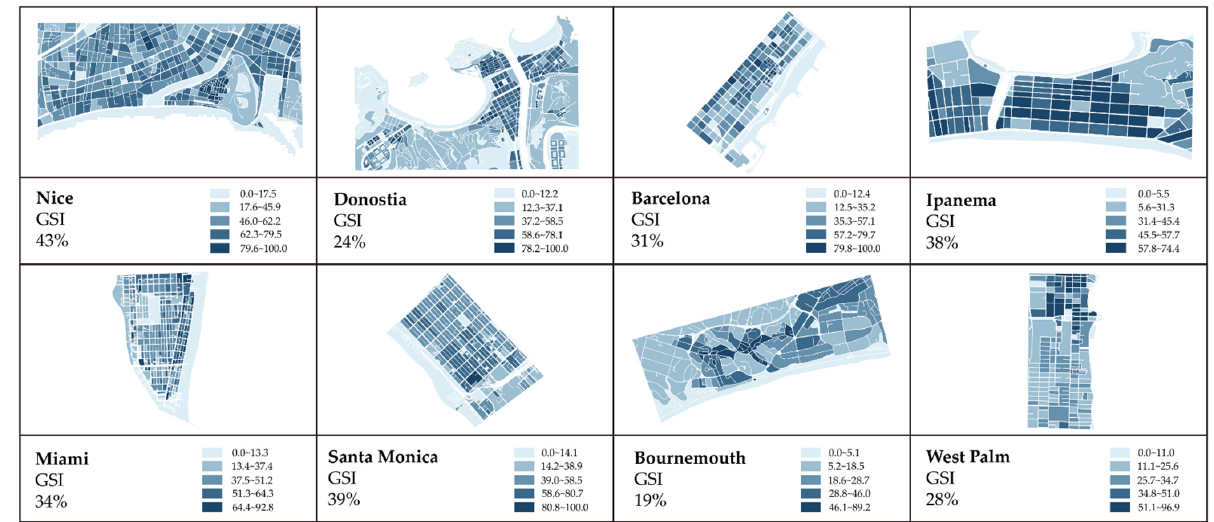
Figure 12. The distribution of GSI in successful coastal cases.